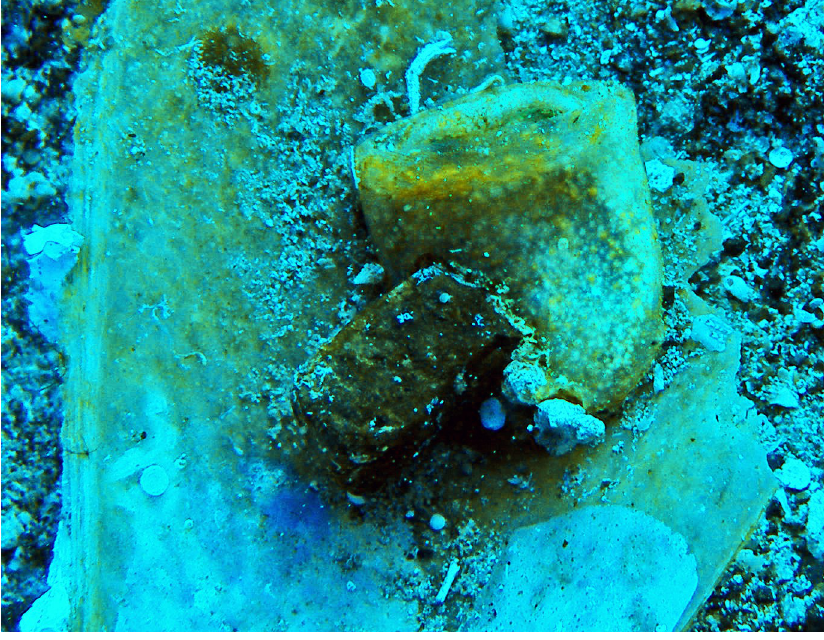
Fig 1. Underwater photograph of Rhodosoma turcicum observed on a dead Pinna nobilis shell in Fethiye Bay (Levantine Sea). Photograph by Melih Ertan C¸INAR.